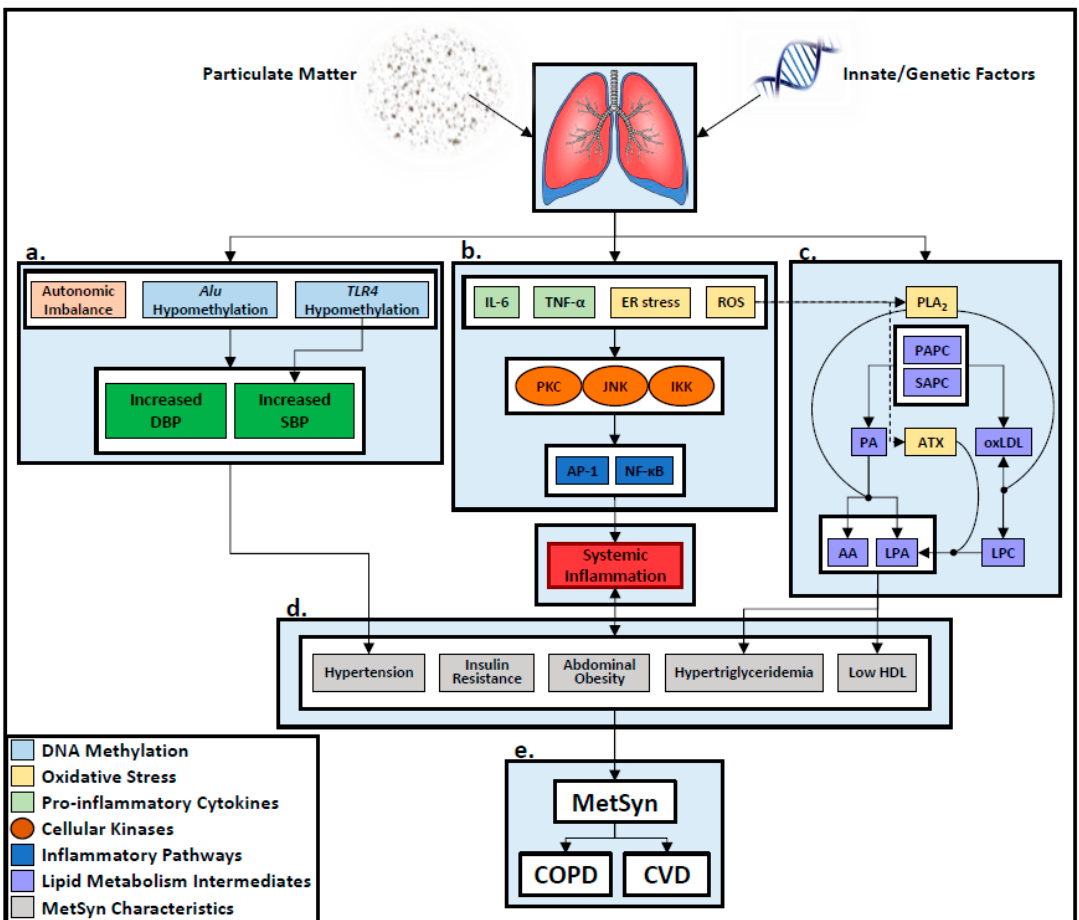
Figure 1. Schematic of biological mechanisms underlying PM-induced MetSyn, COPD, and CVD. ( a ) PM- associated Vascular Effects: PM exposure leads to the hypomethylation of TLR4, which may increase systolic blood pressure (SBP) and diastolic blood pressure (DBP), as well as Alu hypomethylation and autonomic imbalance, which may elevate DBP. Increased SBP and DBP contribute to the development of hypertension, a key feature of MetSyn. ( b ) PM associated MetSyn Phenotype Development: Inhalation of PM elicits the generation of reactive oxygen species (ROS), ER stress, and elevated cytokine levels, such as TNF- α , and IL-6, which in turn activates signal transduction cascades by inducing the activity of cellular kinases (JNK, PKC, IKK). Kinase activation can directly lead to systemic inflammation or do so indirectly by first activating inflammatory pathways (AP-1, NF- κ B). ( c ) PM-associated Lipid Changes (ATX Autotaxin; LPC lysophosphatidylcholine; PLA phospholipase; PAPC 1-palmitoyl-2-arachidonoyl-sn-glycero-3- phosphocholine; SAPC 1-stearoyl-2-arachidonoyl-sn-glycero-phosphocholine; oxLDL oxidized LDL; PA phosphatidic acid). ( d ) Systemic Inflammation contributes to the development of insulin resistance, abdominal obesity, hypertriglyceridemia, and low HDL, all of which are defining characteristics of MetSyn. ( e ) MetSyn then increases affected individuals’ risk of developing COPD and CVD. Lines with no arrowhead ( ) indicate enzymatic contribution to downstream catabolic reactions.